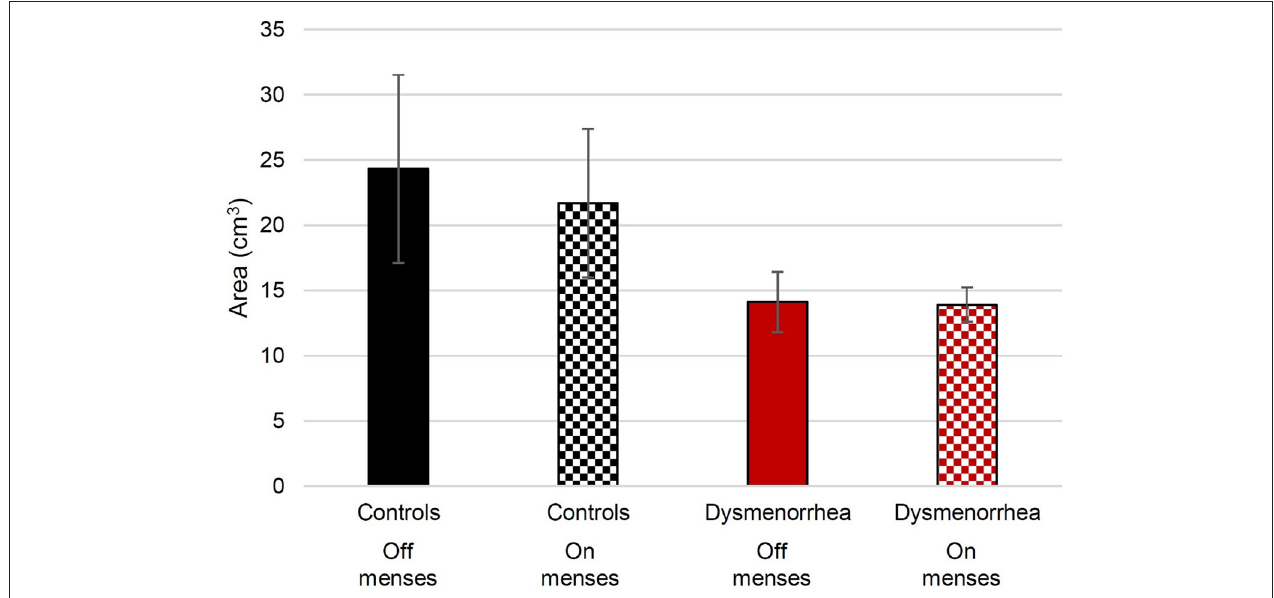
FIGURE 1 | The average volume of measured intraluminal sigmoid colon gas in pain-free control participants and women with dysmenorrhea. The error bars show the standard error of the mean.